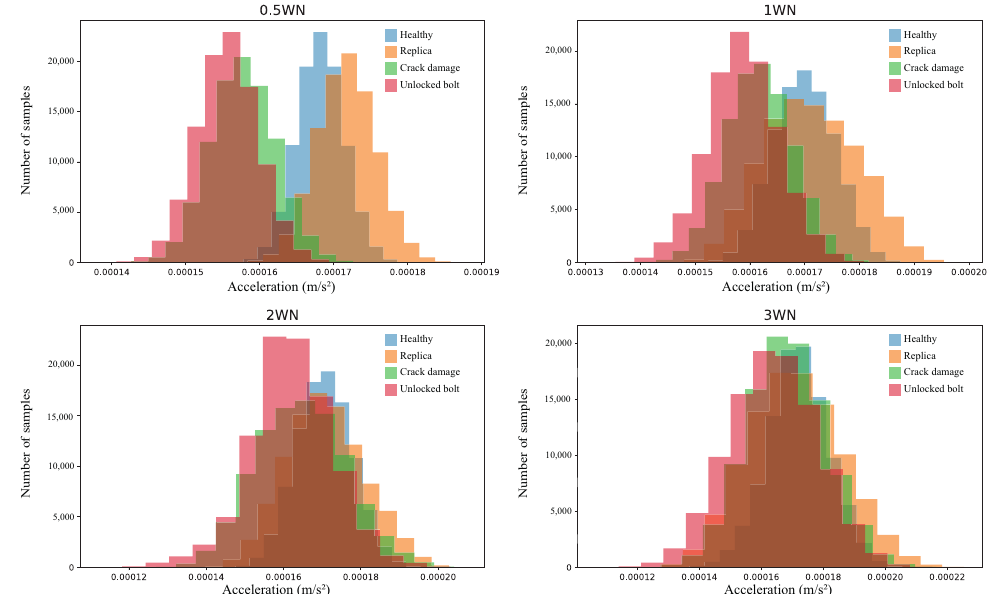
Figure 4. Histograms for each structural state (blue stands for the healthy state, orange for the replica bar, green represents the crack damage, and pink is related to the unlocked bolt state) and for each different white noise (WN) amplitude factor.